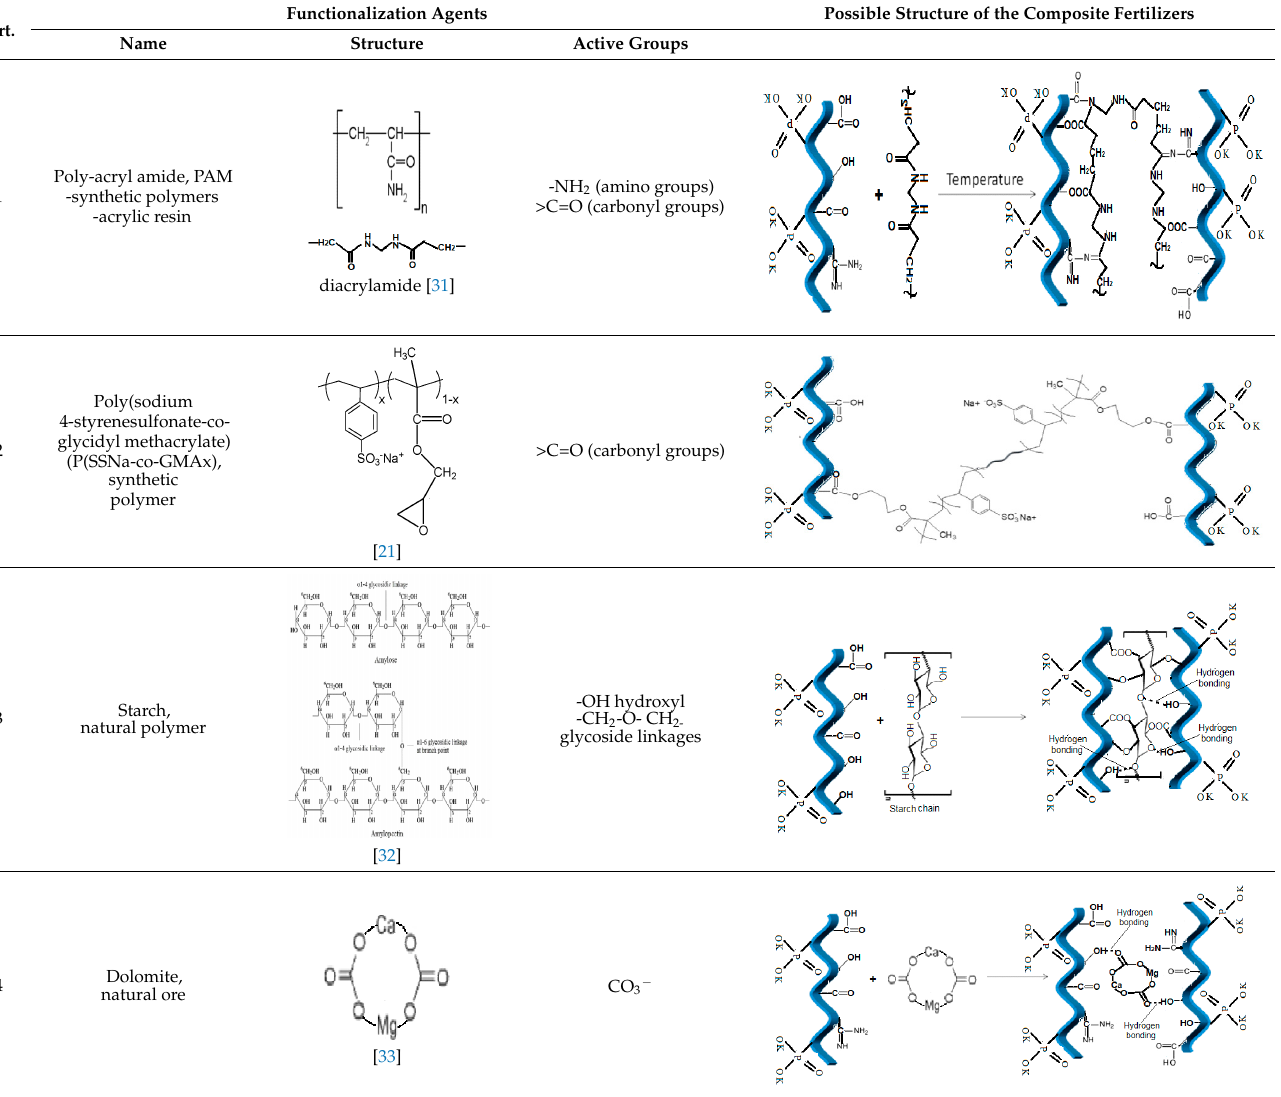
Table 6. Possible structures of the collagen hydrogel fertilizers with various functionalization agents. Crt.